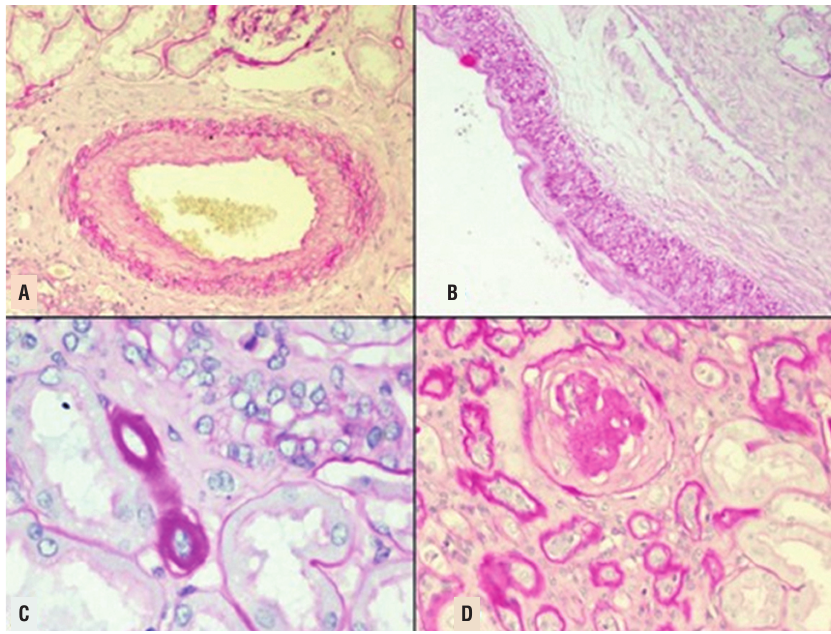
figure 1 - histopathological factors (h&E): 1A) Arteriosclerosis- Intima more than media; 1B) Arteriosclerosis: Intima less